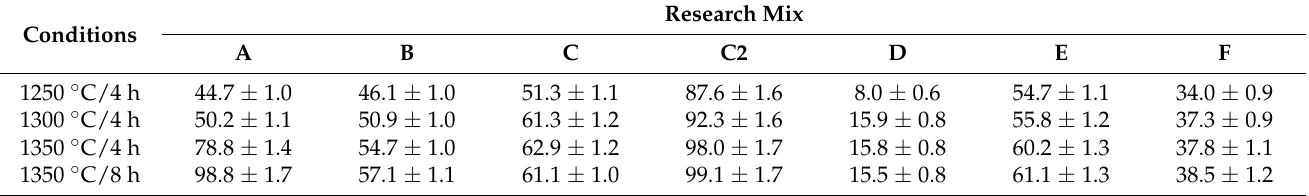
Table 3. Determined amount of ye’elimite (XRD Rietveld method) in synthesized materials.